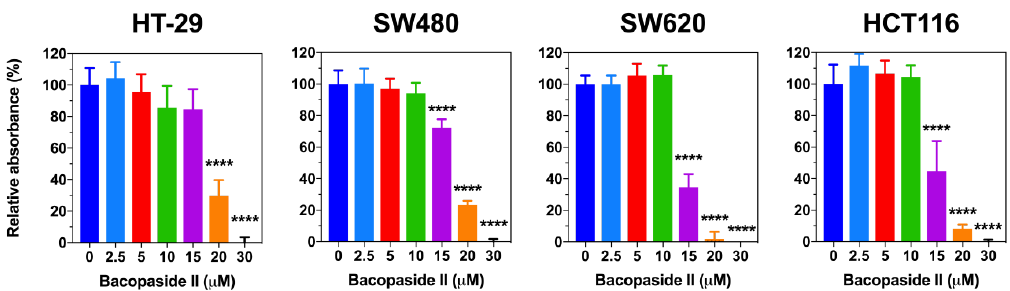
Figure 2. Effect of bacopaside II on adherent colon cancer cell growth. Cells were treated with bacopaside II for 72 h and then cell numbers were determined using crystal violet staining. Data are the mean ± SD of six replicates, relative to vehicle control (0 µM bacopaside II) treated cells. **** p < 0.0001.